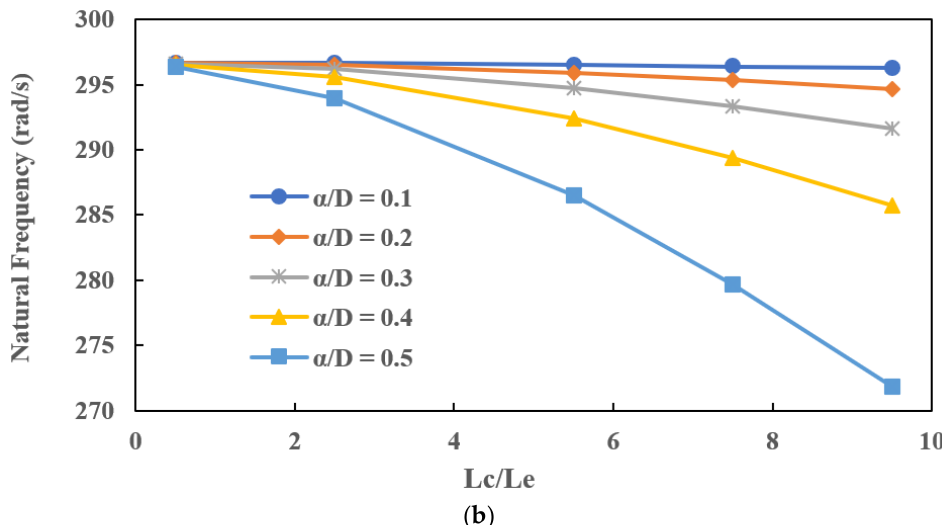
Figure 6. Variation in natural frequencies of a cracked EG rotor − bearing system for different: ( a ) crack depths; ( b ) crack locations.